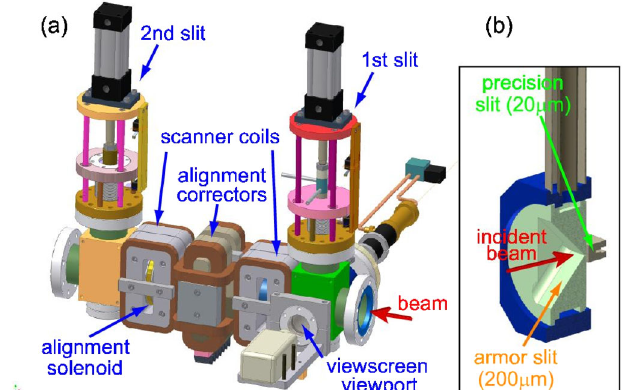
FIG. 3. (Color) (a) The emittance measurement system. A beam scanner (not shown) precedes the 1st slit. (b) Details of the 1st slit showing water-cooled 200 (cid:1) m armor slit and 20 (cid:1) m preci- sion